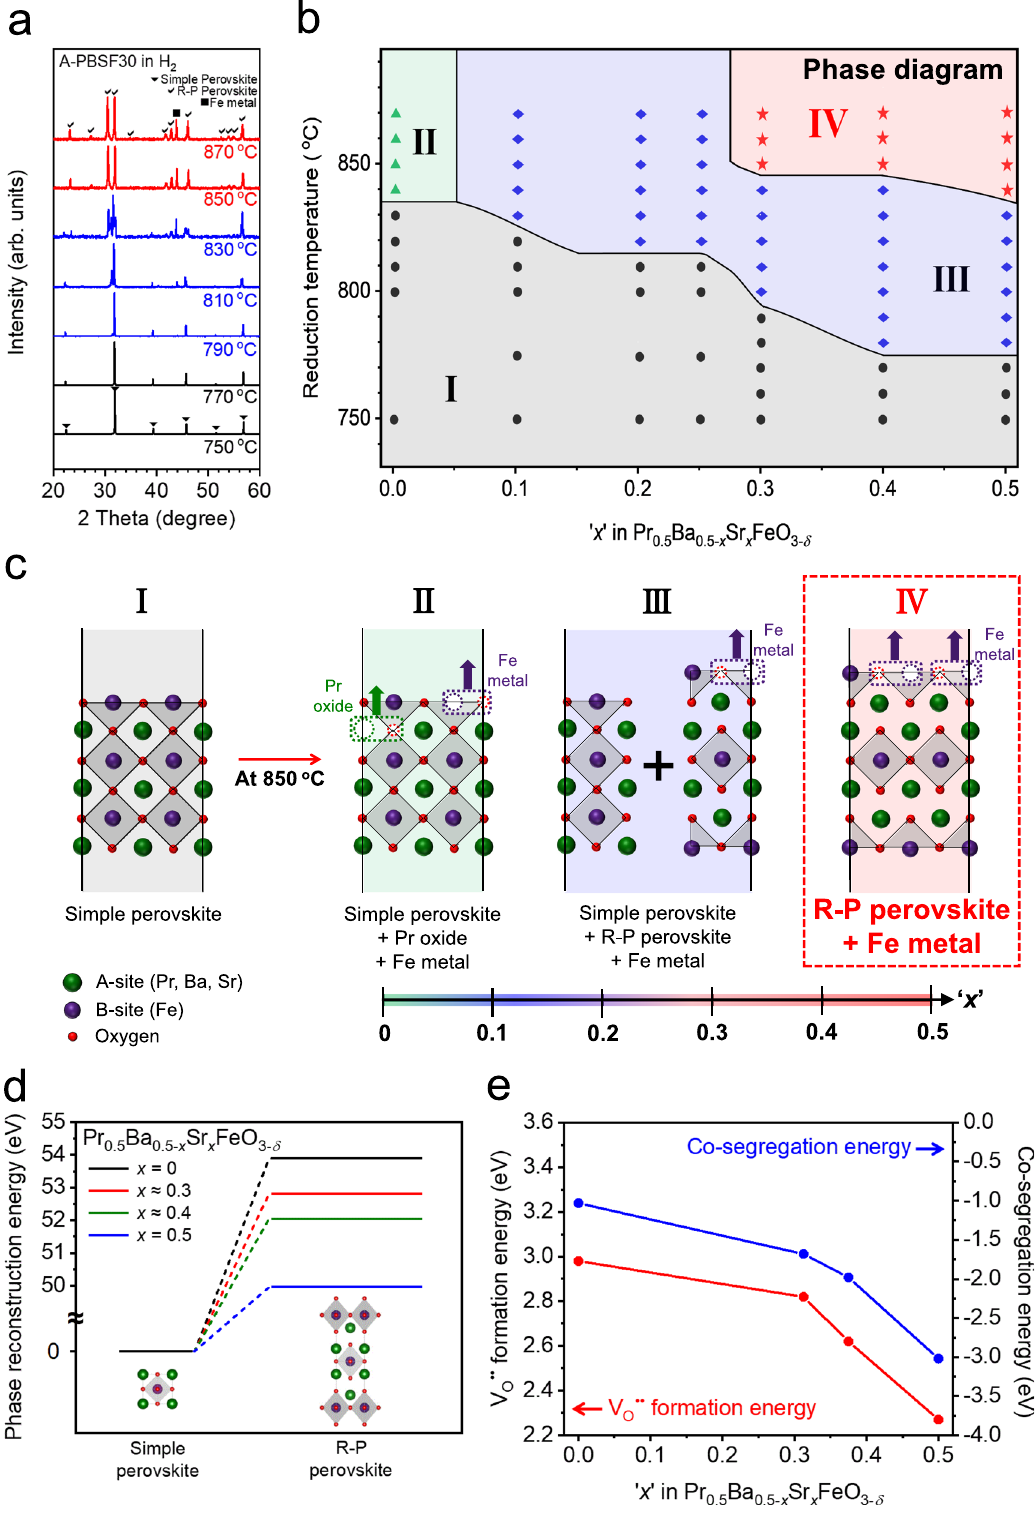
elucidated by the decrease in tolerance factor after replacement of Ba 2 + by Sr 2 + (Supplementary Table 3) 36 . A co-segregation energy (E co-seg ) associated to the degree of exsolution for B-site transition metal cations under reducing condition was also calculated (Fig. 2e). Interestingly, E co-seg decreased as the Sr 2 + contents increased, suggesting the enhanced degree of Fe exsolution with increasing Sr 2 +